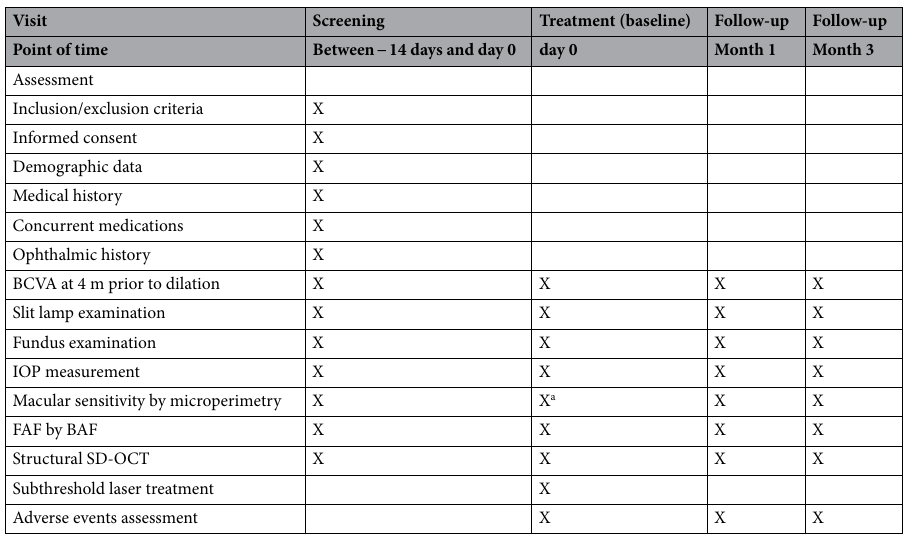
Table 1. Timing of study assessment. BCVA Best-corrected visual acuity, IOP intra-ocular pressure, FAF fundus autofluorescence, BAF blue autofluorescence, SD-OCT spectral-domain optical coherence tomography. a If not executed on screening